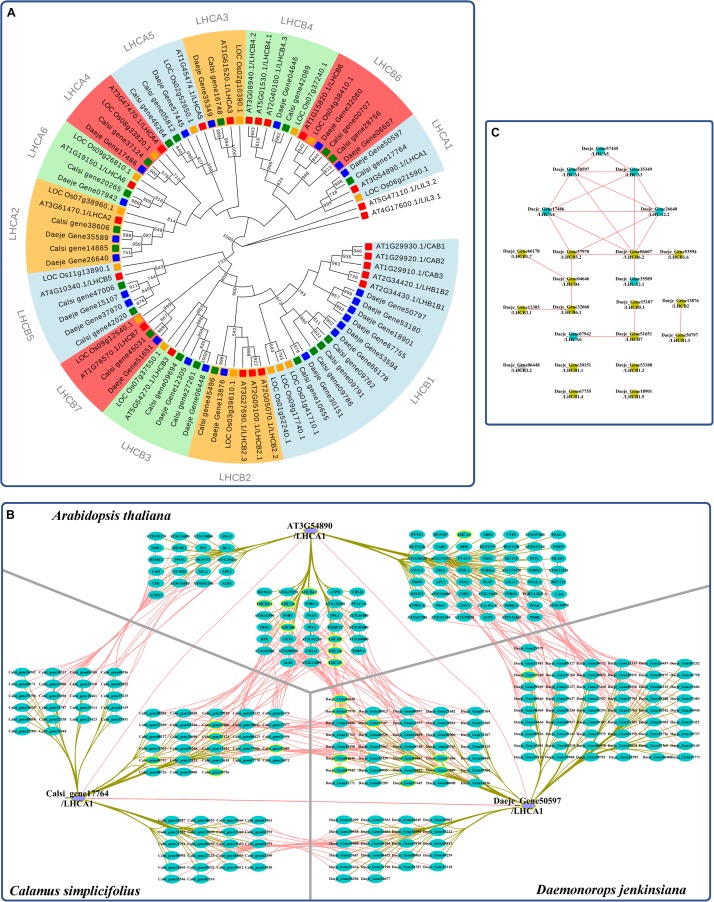
Coexpression analysis of LHC genes in the rattans. (A) Phylogenetic tree of the LHC gene family. The number at the node indicates the bootstrap value. LILs were selected as the outgroup. Green, blue, yellow, and red indicate the genes in C. simplicifolius, D. jenkinsiana, O. sativa, and A. thaliana, respectively. (B) Comparison of genes with the top 300 Pearson correlation coefficient (PCC) values of LHCA1 in C. simplicifolius, D. jenkinsiana, and A. thaliana. The gray and dark yellow lines link the orthologous gene pairs and coexpressed genes, respectively. LHC genes are bordered with a yellow line. (C) The coexpression network between LHC genes in D. jenkinsiana. The blue and yellow dots are LHCA and LHCB genes, respectively. The gray dot indicates that there is no coexpression network for the gene. Red lines link the coexpressed gene pairs and indicate a positive coexpression relationship.